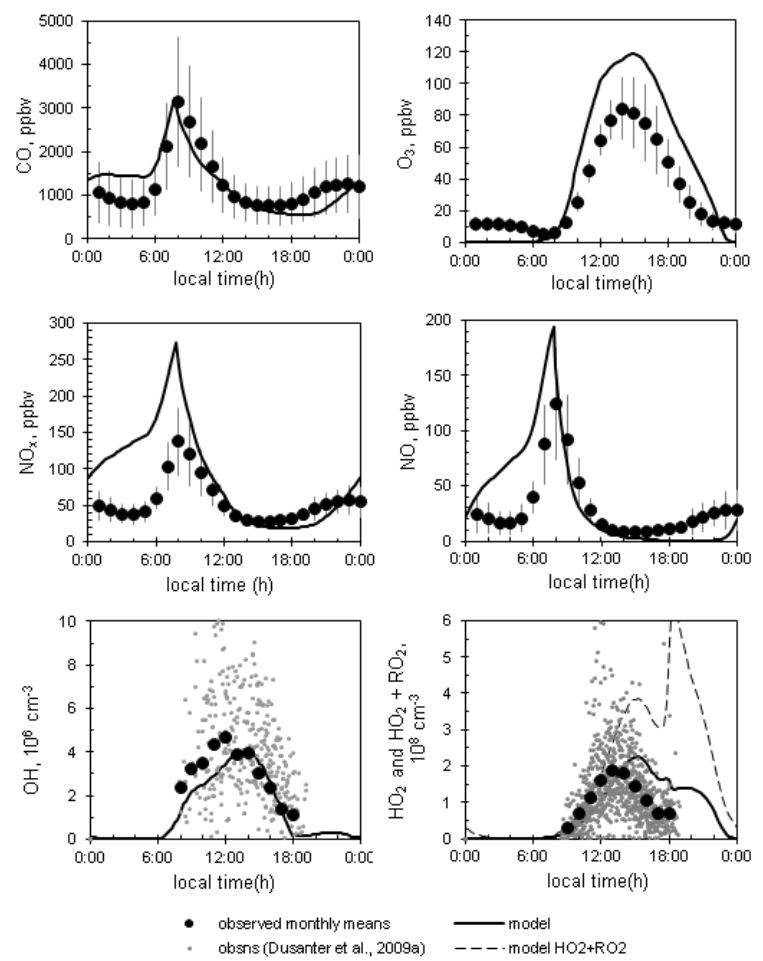
Fig. 3. Modeled diurnal cycles of major inorganic gases in Mexico City during March 2006. Hourly mean observations for CO, O 3 , NO and NO x are citywide averages for the entire month, with error bars showing one standard deviation about the mean (SIMAT). Hourly mean observations of OH and HO 2 are from T0 between 14 and 31 March (Dusanter et al., 2009a). No RO 2 observations are